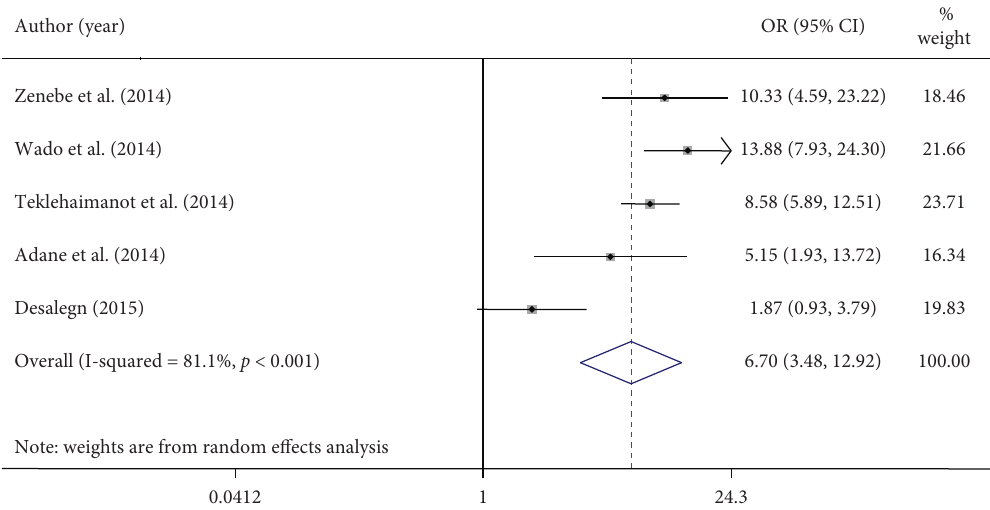
Figure 6: Forest plot displaying the association of pregnancy-induced hypertension on low birth weight in Ethiopia.